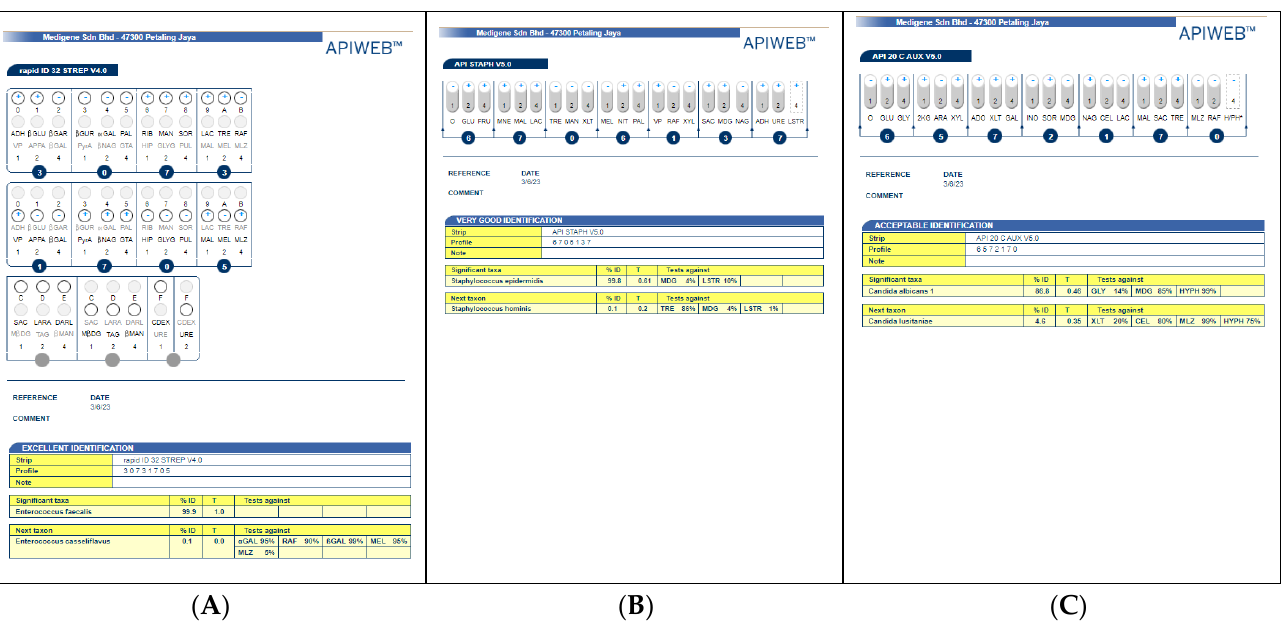
Figure 4. ( A ) API identification of E. faecalis; ( B ) API identification of S. epidermidis ; ( C ) API identification of C. albicans.